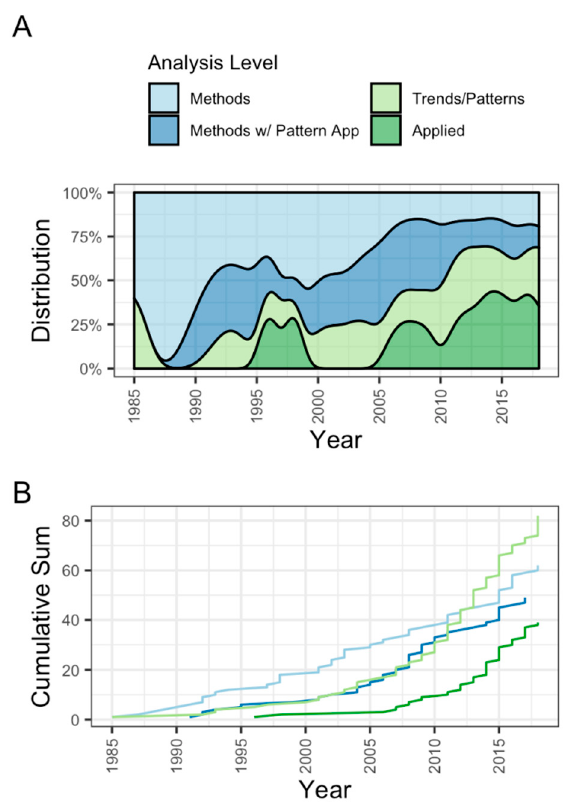
Figure 7. Distribution of publication focus through time ( A ). Cumulative sum totals ( B ) for methods categories (n = 113; 49%), trend / pattern papers (n = 81; 35%), and water quality science papers (n = 38; 16%) show decreasing dominance of methods over time.